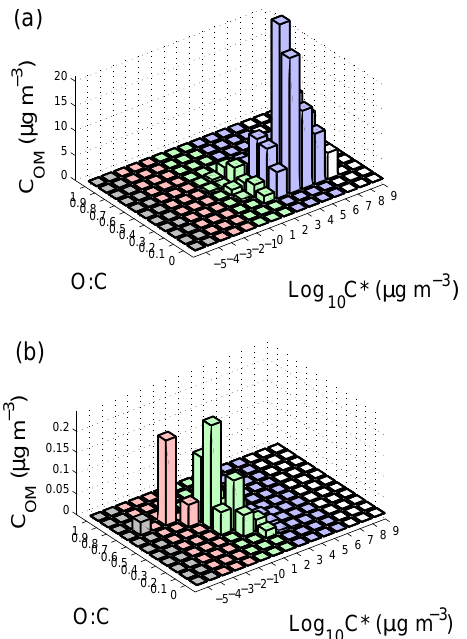
Figure 3. Mass of first-generation products for each cell in the 2D-VBS, from 100µgm − 3 α -pinene + ozone at β = 0 . 15. (a) Total mass of all (organonitrate and non-nitrate) organics in both the sus- pended and vapor phases. (b) Total mass of all organics in only the suspended phase. The suspended phase concentration axis is 2 or- ders of magnitude smaller than the vapor phase; most of the first- generation mass remains in the vapor